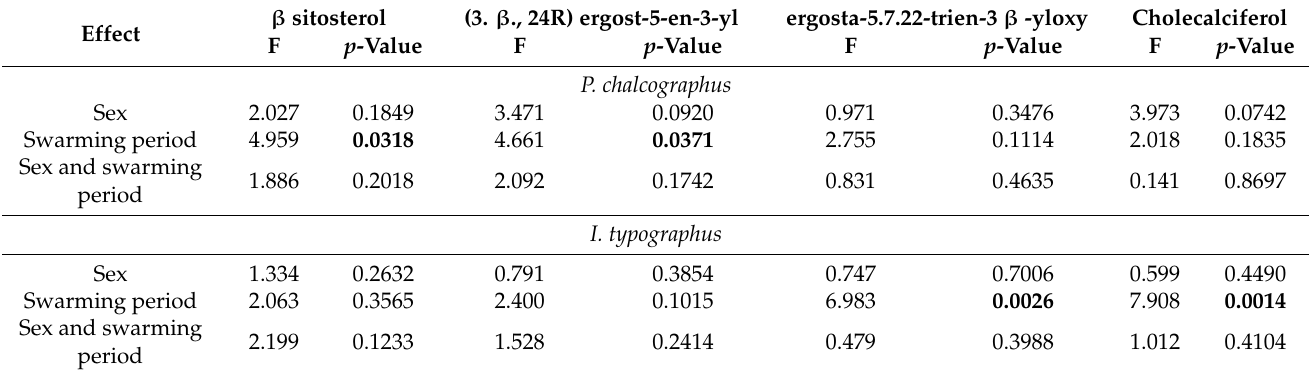
Table 1. Results of multivariate analysis of variance based on the general linear model (GLM) for the concentration of sterols, including the beetle sex and swarming period as quality